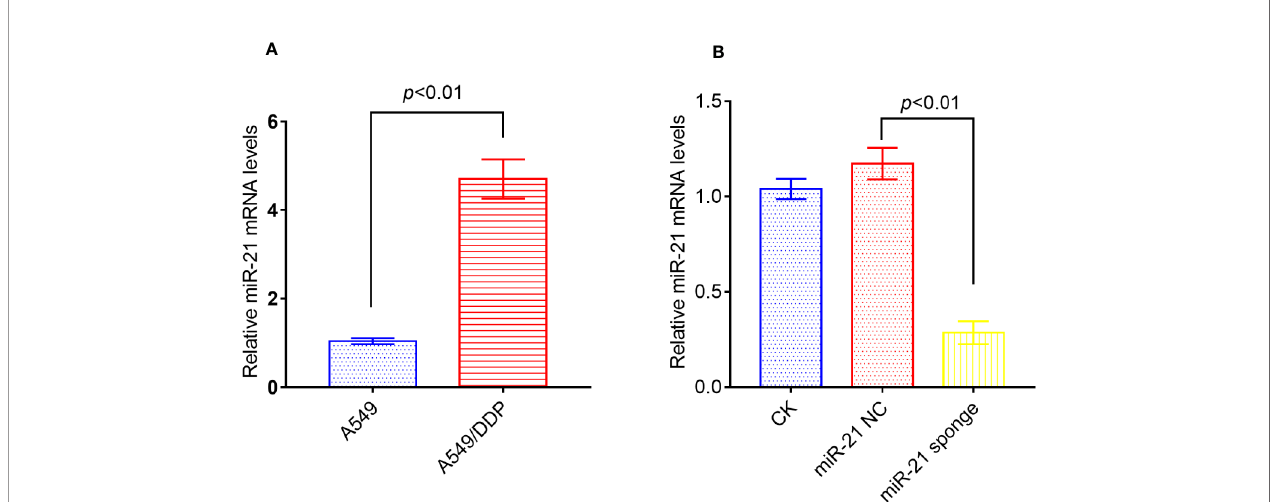
FIGURE 4 | TheexpressionofmiRNA-21increasedinA549/DDPcells,andthetransfectionofmiRNA-21spongeinhibitedtheexpressionofmiRNA-21.Theexpressionof miRNA-21wasmeasuredinA549cellsandA549/DDPcells (A) .TransfectionofmiRNA-21intoA549/DDP cells caninhibittheexpressionofmiRNA-21 (B) . Theexperiments wererepeatedatleastthreetimesandresultswereexpressedas mean± S.D.